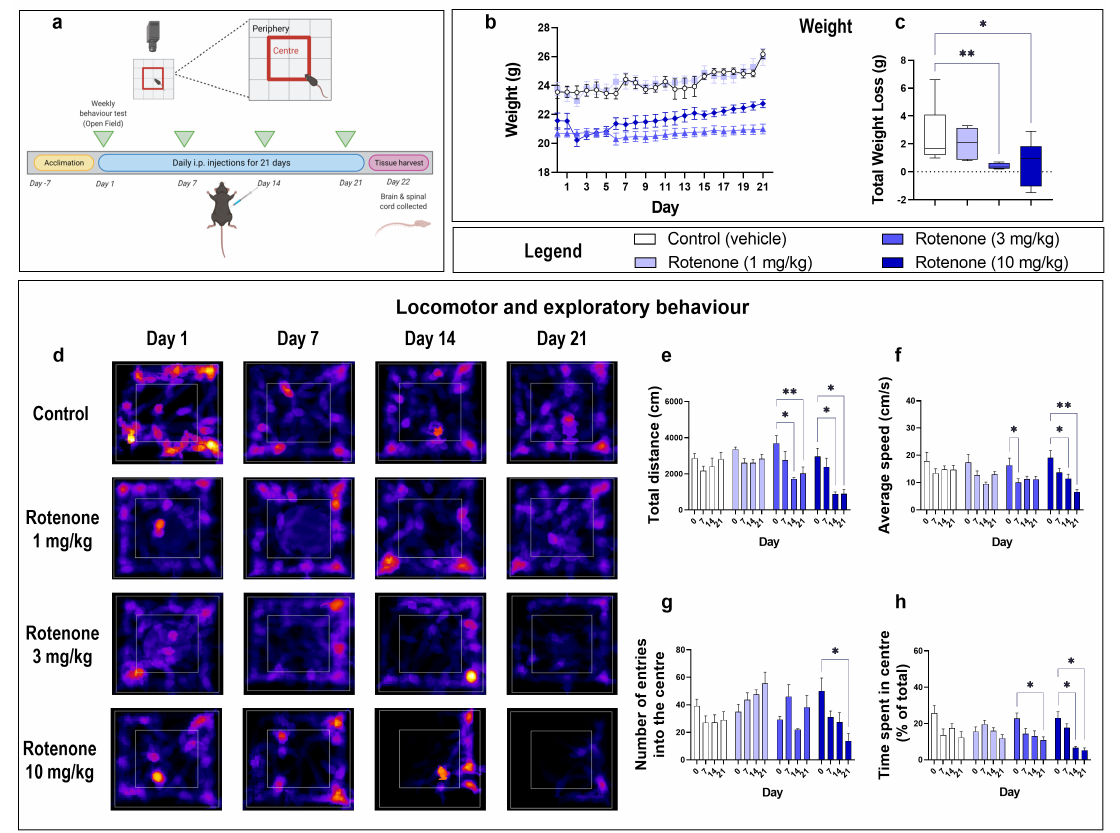
Figure 1. Rotenone impairs locomotor and exploratory behaviour. Experimental timeline for injec- tions and behavioural assessments ( a ). The Open Field Test mice was used to assess for locomotor and exploratory behaviour in rotenone Vs baseline measurements every 7 days. The centre quadrant was defined as a central square with a surface area that is 25% smaller than the total area (red box), whereas the peripheral area was defined as the surface area between the centre quadrant the walls of the Open Field box. Mice received an intraperitoneal injection of indicated treatment daily for 21 days. On day 22, mice were humanely sacrificed and the brain and spinal cord was collected. Mean daily weight per treatment group ( b ) and the average weight loss/gain ( c ) was calculated using mean daily weights of day 1 vs. day 22. Representative heat maps from MouBeAt Software that tracks the movement of mice during the open field ( d ). Locomotor and behaviour measurements were determined by MouBeAt software. Heat map uses colour to represent how often a mouse spent in an area. The longer a mouse spent in an area, the colour would shift from blue to red to yellow. Comparisons were made within the same treatment group compared to baseline measurements. An entry into an area was counted when at least 7% of the mouse body had completely entered the area. Total distance travelled (cm) in 5 min ( e ). Average speed reported as cm/s ( f ). Number of entries in centre ( g ). Time spent in centre(s) ( h ). Data shown represents means of n = 6–10 mice per group. * p < 0.05 or ** p < 0.01 as determined by one-way ANOVA followed by Dunnett’s post hoc test (weight change) or two-way repeated measures ANOVA followed by Tukey post hoc test (behavioural